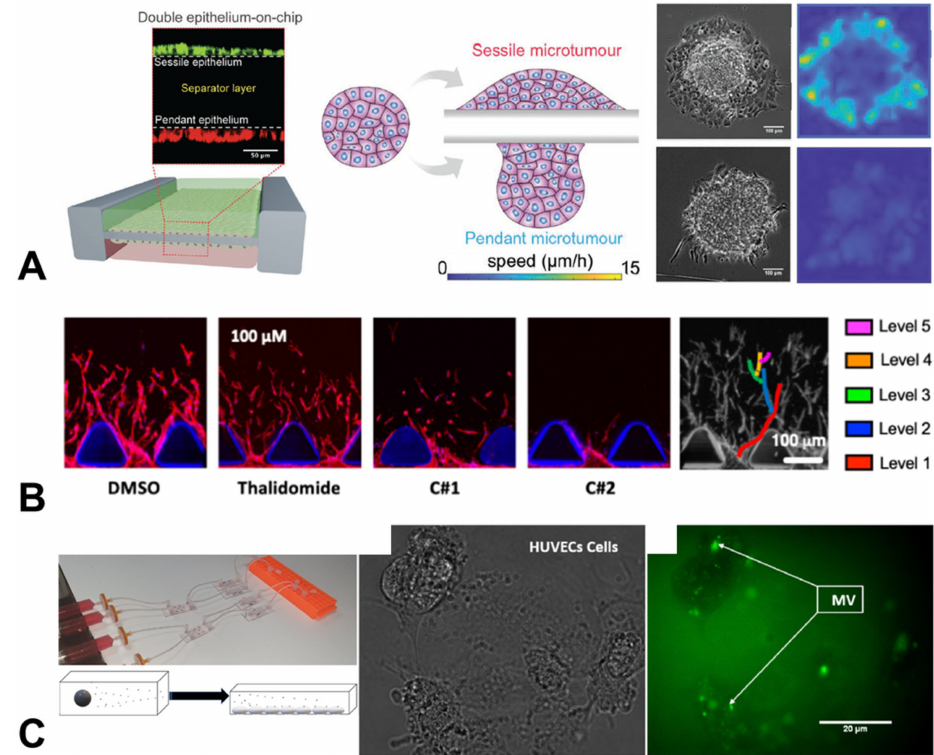
Figure 4. Organ-chip models of cancer-associated behaviours. ( A ) The spreading speed of liver micro- tumour spheroids depended on the epithelial layer on which they are placed (scale bar = 100 µ m) [44]. ( B ) Angiogenic sprouting, modelled and analysed in a microfluidic chip under a range of different anti-angiogenic drug treatments (thalidomide, C#1, C#2) (scale bar = 100 µ m) [45]. ( C ) Chips placed in series allowed the monitoring of the uptake of procoagulant microvesicles secreted by glioblastoma and ovarian carcinoma cells (MV, green) by human endothelial cells (scale bar = 200 µ m) [46]. Figures reproduced with